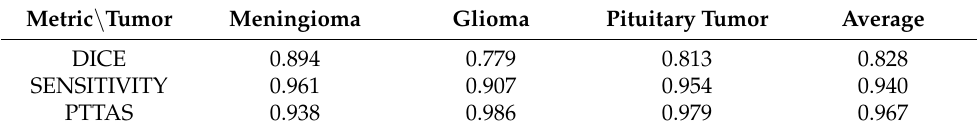
Table 1. Segmentation metrics of the 3064 slices processed with 5-fold cross validation.